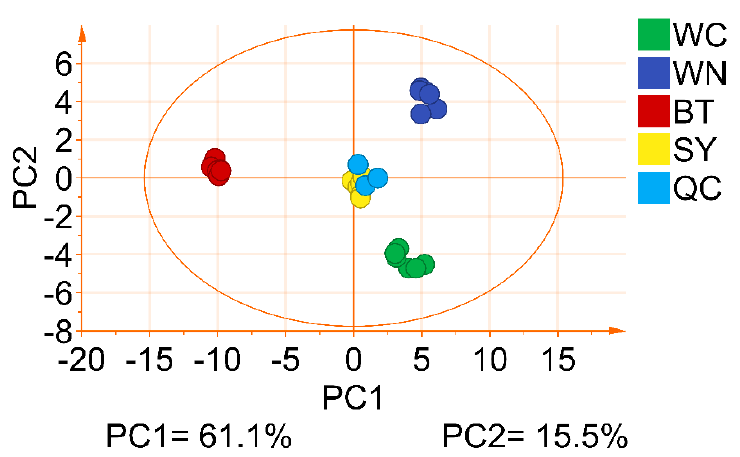
Figure 5. 2D scores plot of the first two principal components based on PCA of polyphenols and alkaloids content, used for identifying partridge tea from four origins (SY, WN, WC and BT).